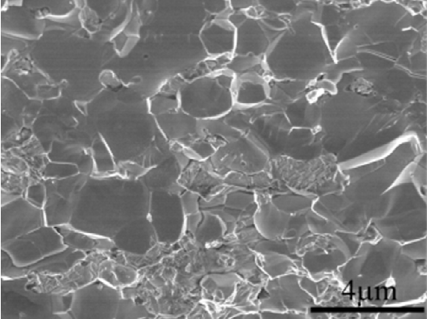
SEM photograph of fracture surface of (Ti 0.2 Zr 0.2 Nb 0.2 Mo 0.2 W 0.2 )Si 2 HES SPSed at 1300 ℃ for 15